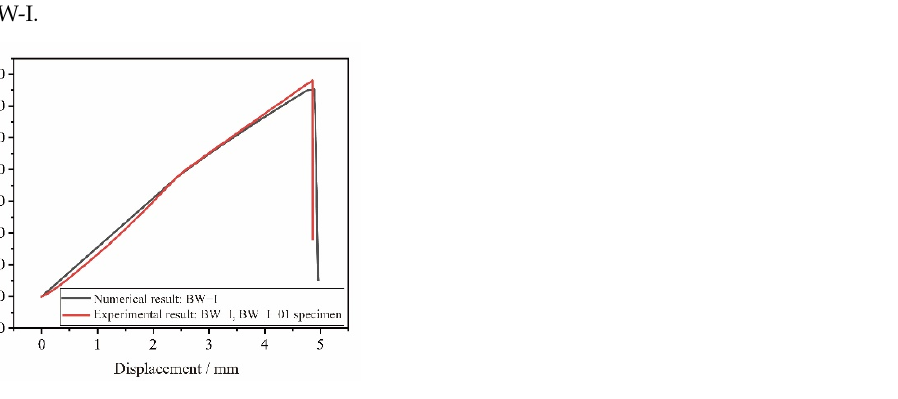
Figure 27. Comparison of the experimental and numerical load-displacement curves for the compo- site beam of BW-I.